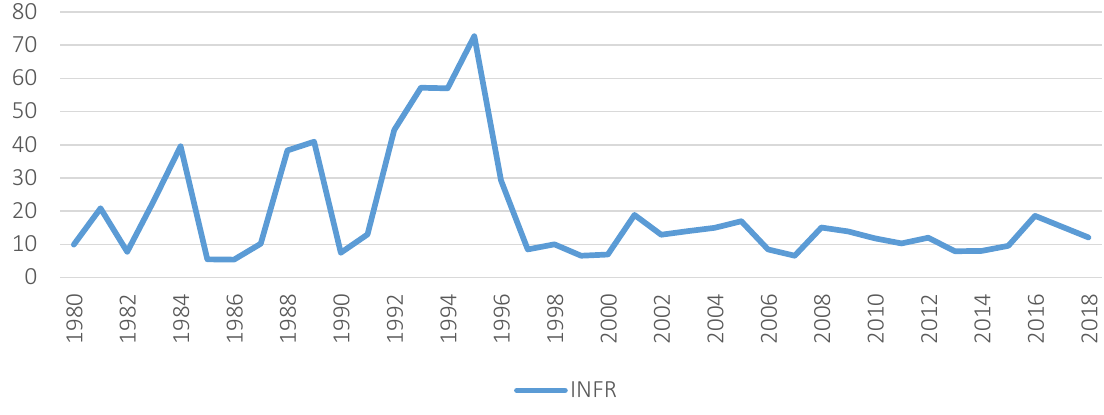
Figure 1. Inflation trend in